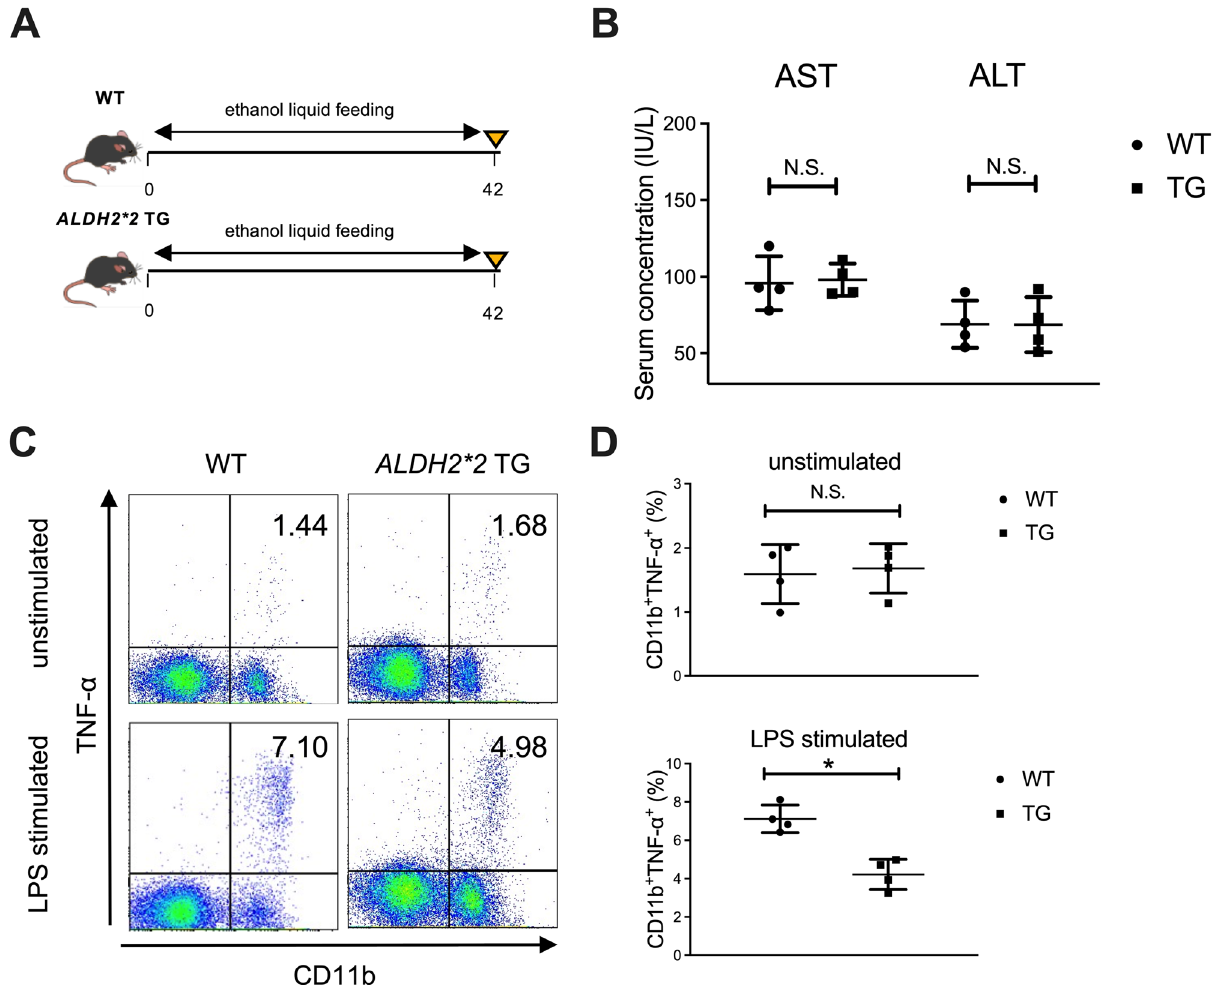
Figure 6. Productivity of inflammatory cytokines from hepatic macrophages in response to LPS stimulation is significantly suppressed in ALDH2*2 transgenic (TG) mice chronically fed ethanol. ( A ) Study design. WT mice (n = 4) or ALDH2*2 TG mice (n = 4) received a control liquid diet for 5 days and 5% ethanol liquid diet for 6 weeks. ( B ) Serum aspartate aminotransferase (AST) and alanine aminotransferase (ALT) levels. ( C ) Representative surface CD11b and intracellular TNF-α staining of liver mononuclear cells derived from the indicated mice either unstimulated (upper) or stimulated with LPS for 4 h (lower). ( D ) Frequency of hepatic TNF-α producing CD11b + macrophages from the indicated mice either unstimulated (upper) or stimulated with LPS for 4 h (lower). Data represent the mean ± SD. * p value < 0.05 by Student’s paired t-test. N.S.: not significant. Data are representative of two independent